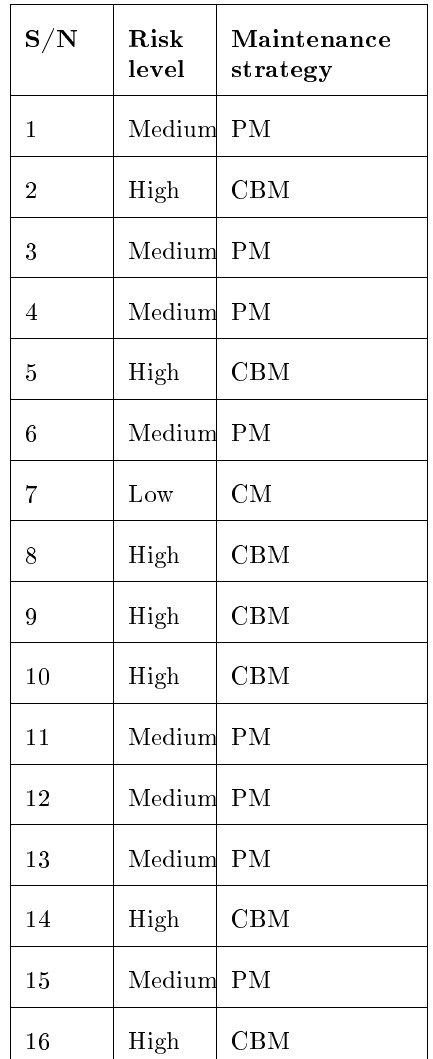
Tab. 14: Failure modes risk (criticality) level and cor- responding maintenance strategy.